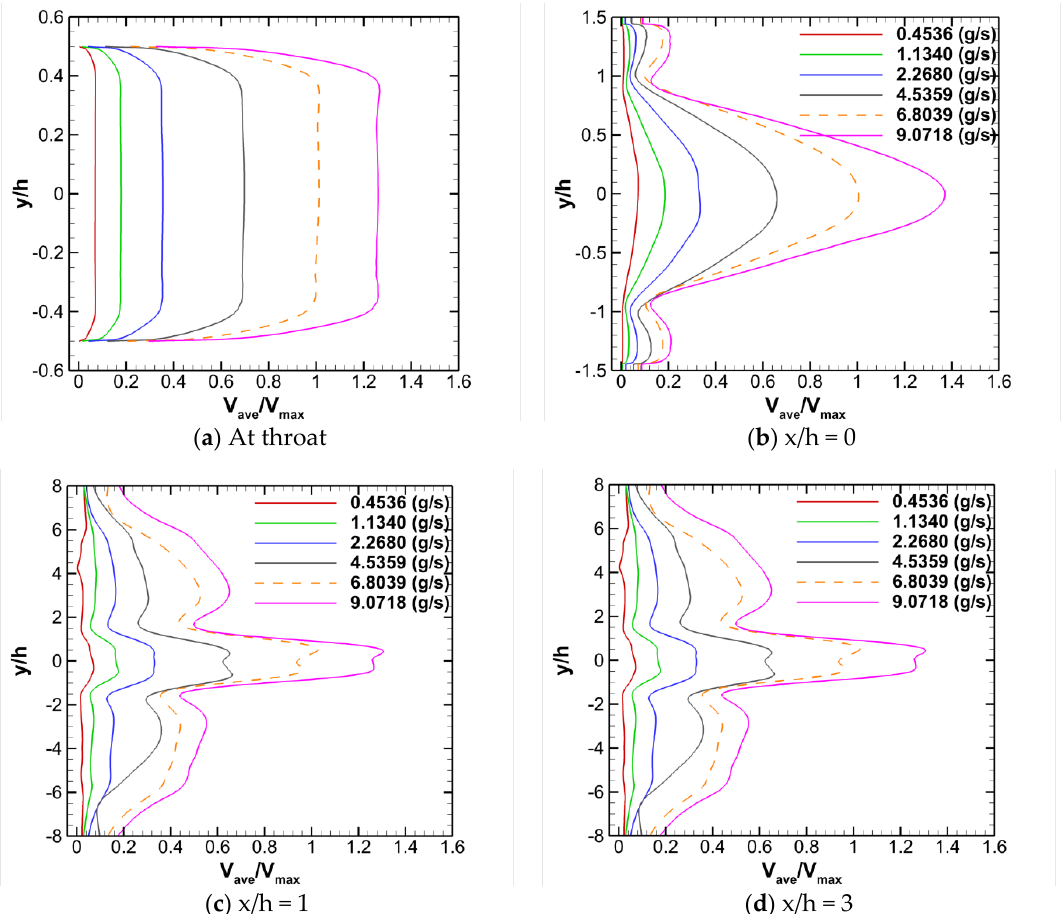
Figure 10. Comparison of mean velocity profiles at various downstream locations ( a ) at the SWJ exit